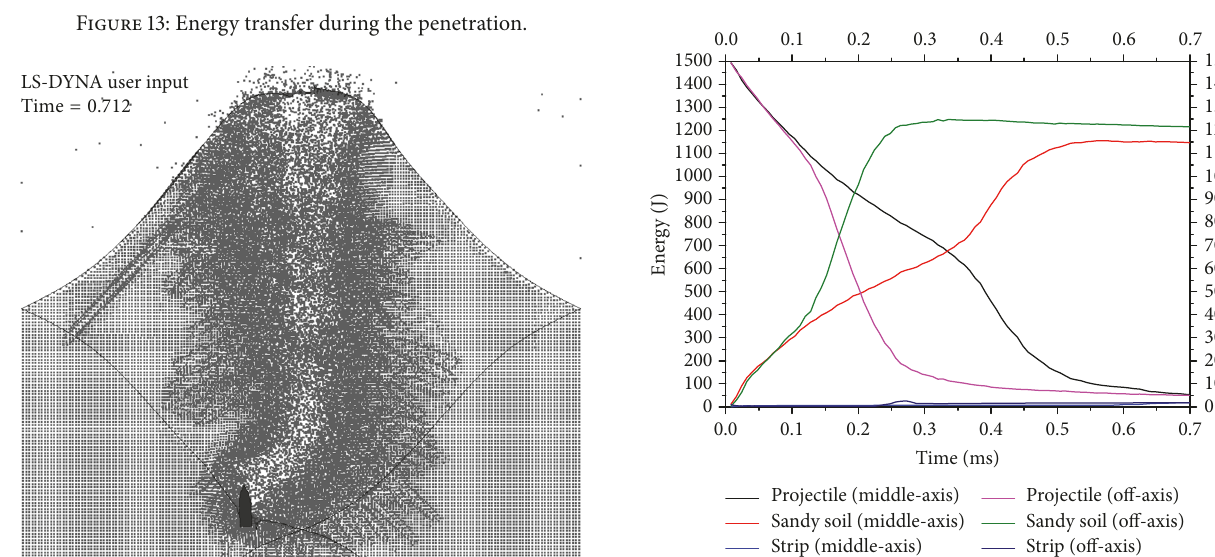
Figure 16: Negative acceleration of MCRB from different POI.